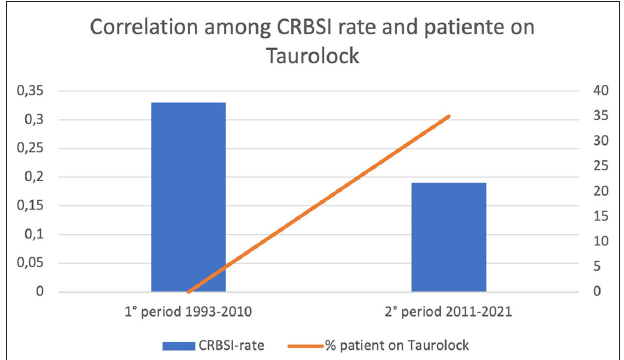
FIGURE 3 | Trends of CRBSI rate reduction and percentage of patients on Taurolock.